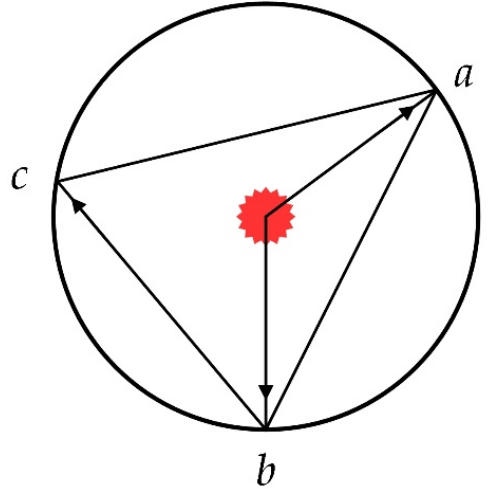
Figure 1. Schematic diagram of illumination composition inside integrating sphere.